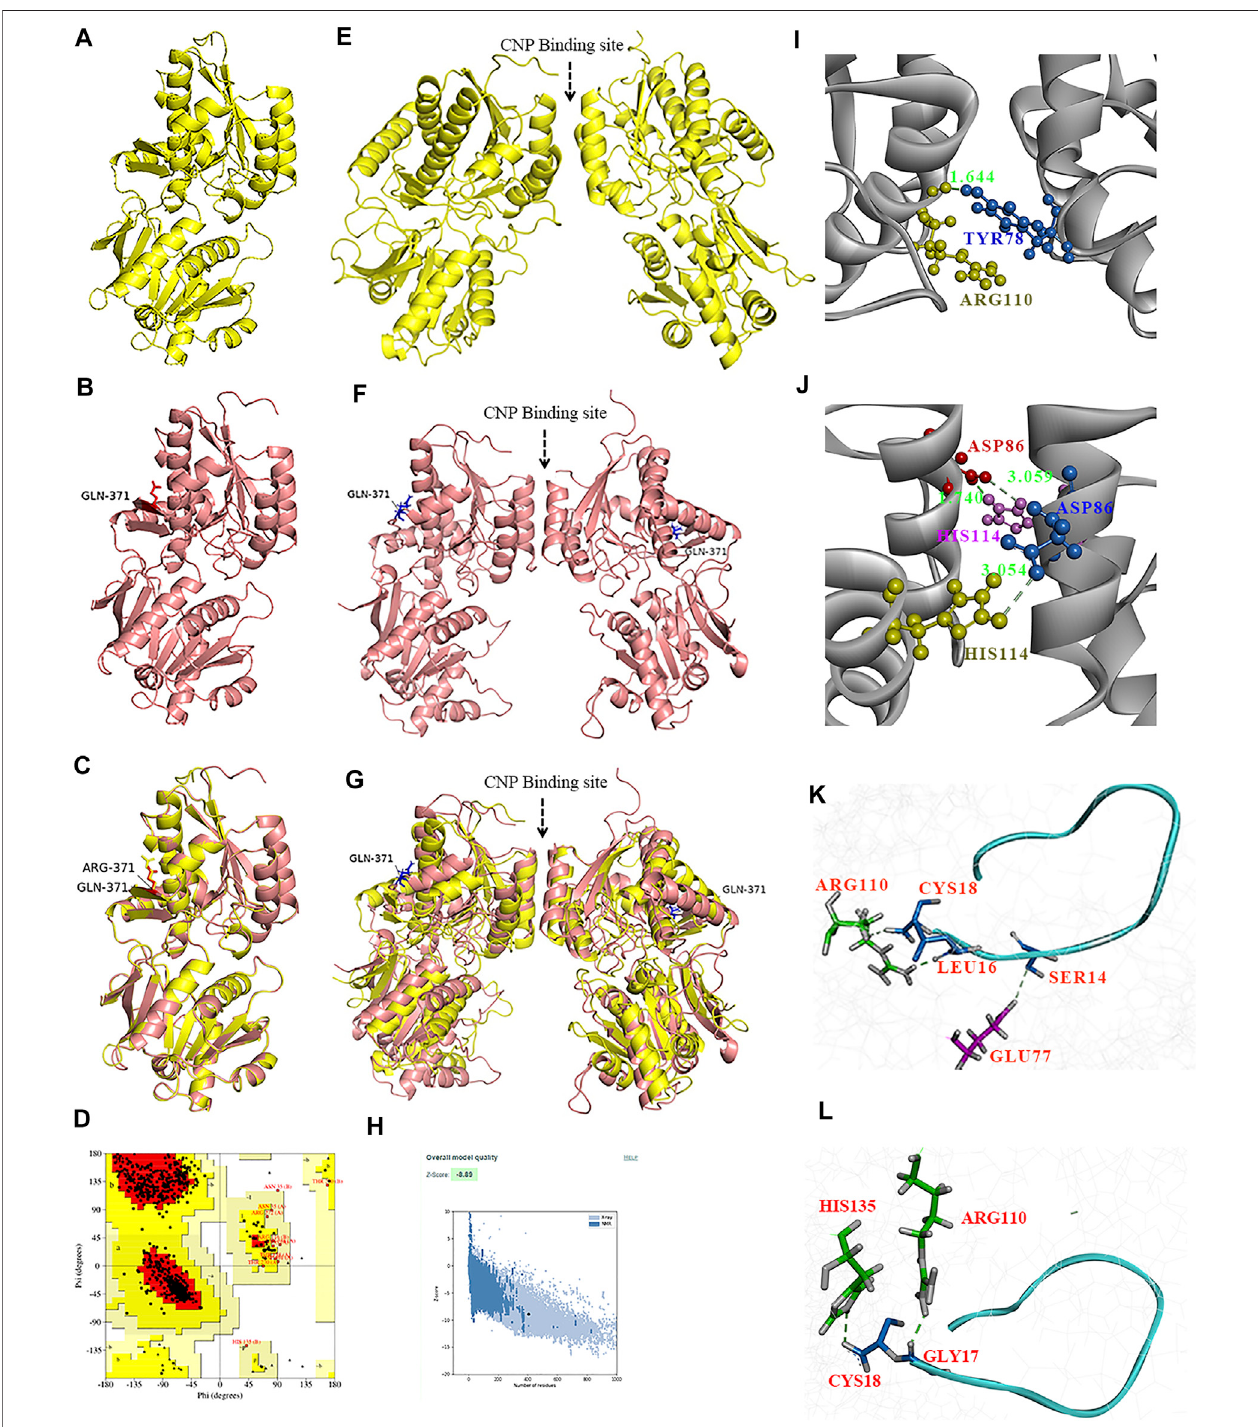
FIGURE5| Homologymodelingofthewildtype andmutantECDofHsNPR2.Athree-dimensionalmodelofthemonomerofECD wt (A) ,monomer ofECD 371Q (B) , and the graphic superimpositionbetweenthemonomerofECD wt and ECD 371Q (C) . Validation ofthe homology ECDdomain model ofHsNPR2. Residuesdistributionof the ECD (D) in the correspondent regions of Ramachandran plot. Z-score validation of the ECD (E) . The MD re fi ned homo-dimer of ECD wt (F) , the MD re fi ned homo- dimer of ECD 371Q (G) and the graphic superimposition of the MD re fi ned homology between ECD wt and ECD 371Q (H) . Comparing to ECD wt , the binding between CNP and the MD re fi ned homodimer of ECD 371Q is arrow-pointed in panel. Structuraland molecular analyses suggestmutant ECD of NPR2 constrictsthe CNP binding site due to enhanced polar interactions in the homodimer (I,J) . One hydrogen bond formation between Try78 and Arg110 in the ECD wt (I) and three hydrogen bonds formation between D86 and H114 (J) . By comparison to ECD wt (K) of NPR2, lessened molecular interactions observed on the ligand CNP to the homodimer of and ECD mt (L) .